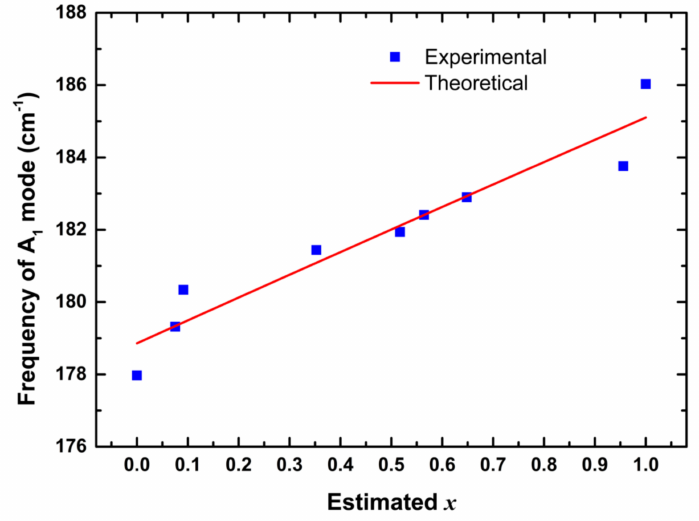
Figure 7. Frequency of A 1 mode of CuIn 1 − x Ga x Se 2 nanocrystals as a function of estimated x